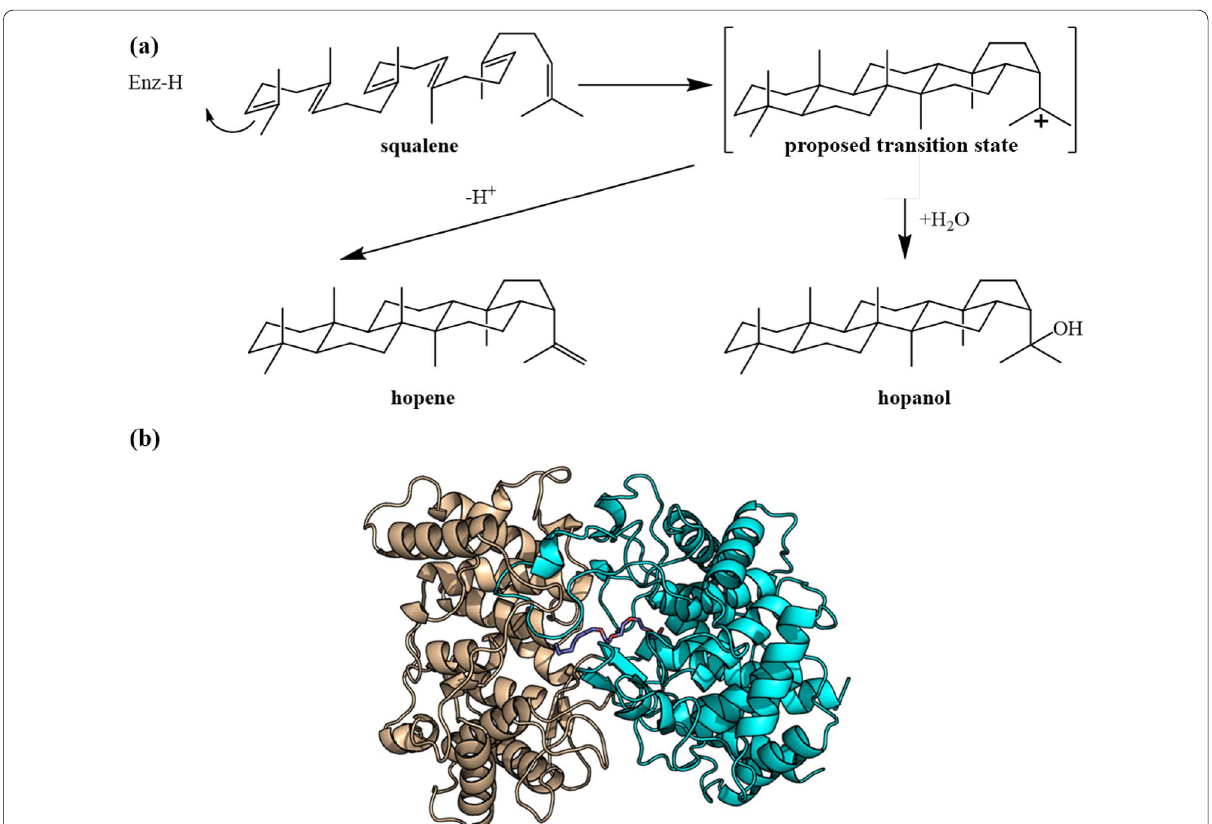
Fig. 19 a Reaction catalyzed by SHC. b Structure of